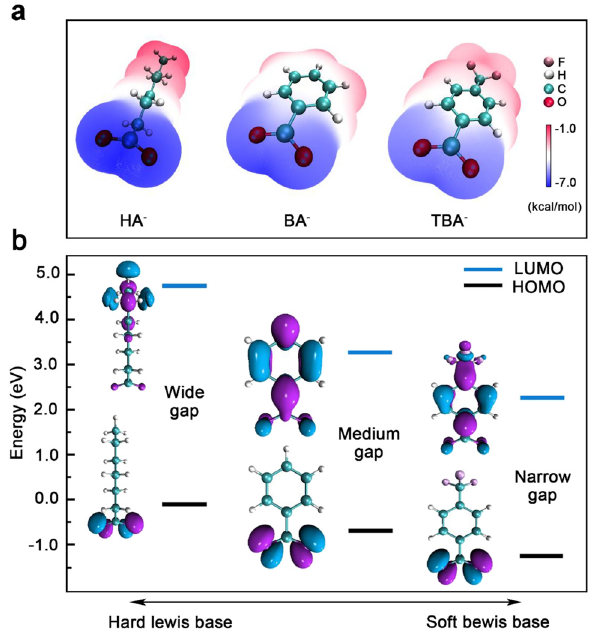
Figure 1: Molecule structures of different carboxylate